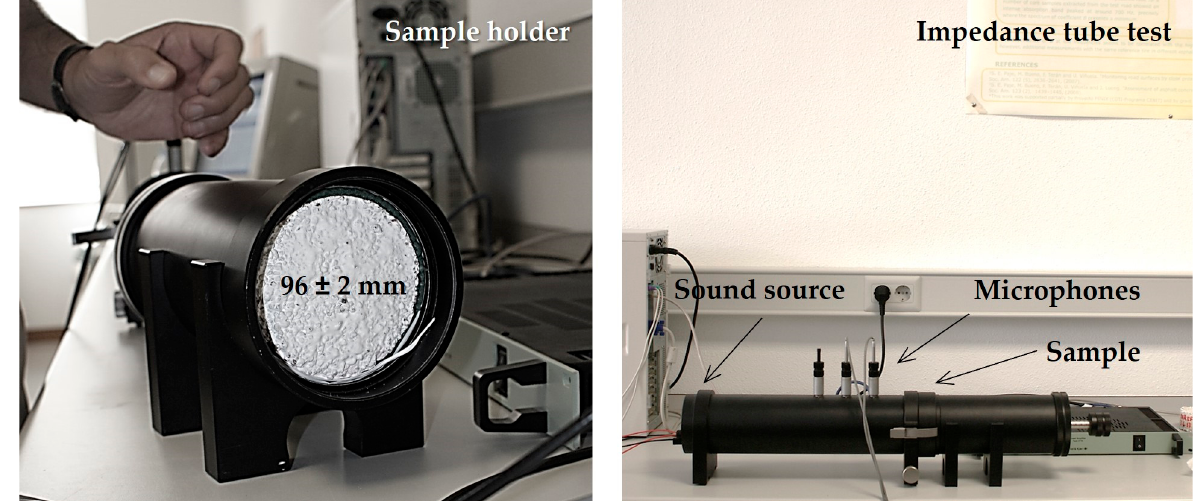
Figure 1. Impedance tube set-up for measuring sound absorption on cylindrical specimens. Noise insulation was experimentally evaluated with the sound reduction index (R A ) measured in a reduced scale acoustic chamber [12,32] on 220 × 240 mm 2 mortar samples with a thickness of 24 ± 2 mm (Figure 2). The acoustic chamber (Figure 3) consisted of two compartments acoustically insulated (Emitting—E and Receiving—R) separated with a mortar sample (M) placed on a 150 × 150 mm 2 gap. The perimeter of the sample was conveniently insulated to avoid acoustic bridges and edge noise. A 100 dBA pink noise sound source (A) was placed in the emitting compartment and the acoustic pressure was measured in thirds of an octave with three sound-level meters (S) placed inside both compartments and outside the acoustic chamber, according to the European standard UNE-EN ISO 10140-4 [33]).